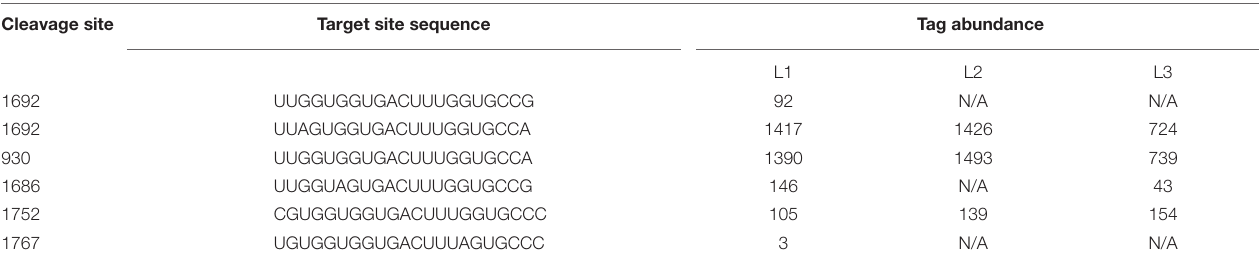
A comparison of miR397a precursor sequences against Robusta 5 de novo genome assembly identified four contig sequences ( Figure 6A ); two of which aligned to the same regions of chromosome 5 and chromosome 10, respectively, of the Golden Delicious Double Haploid genome (Daccord et al., 2017).